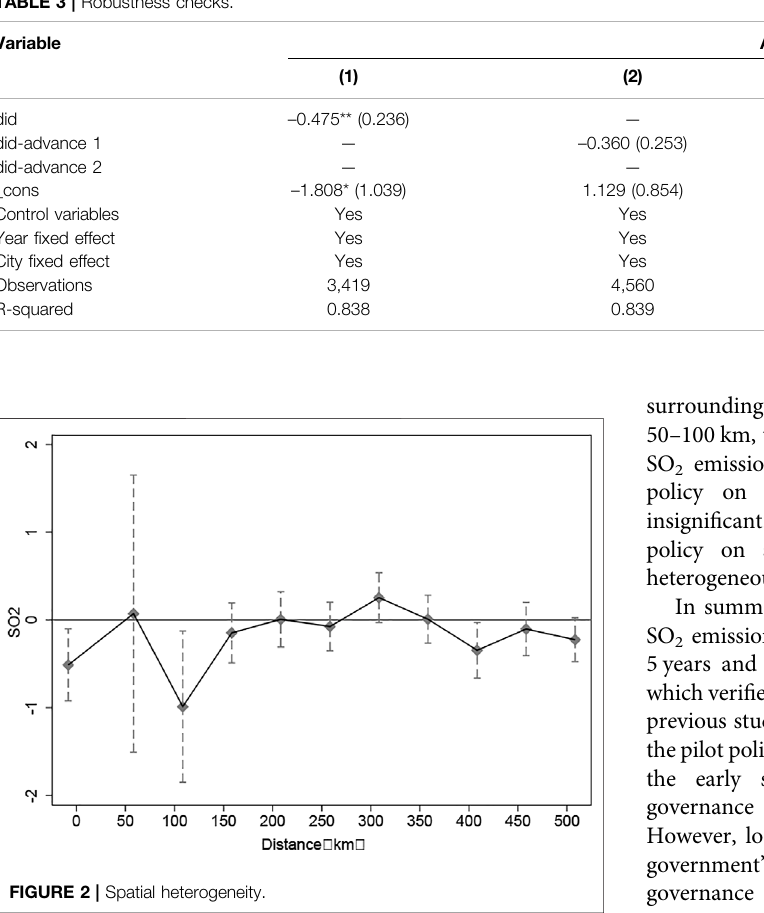
TABLE 3 | Robustness checks.